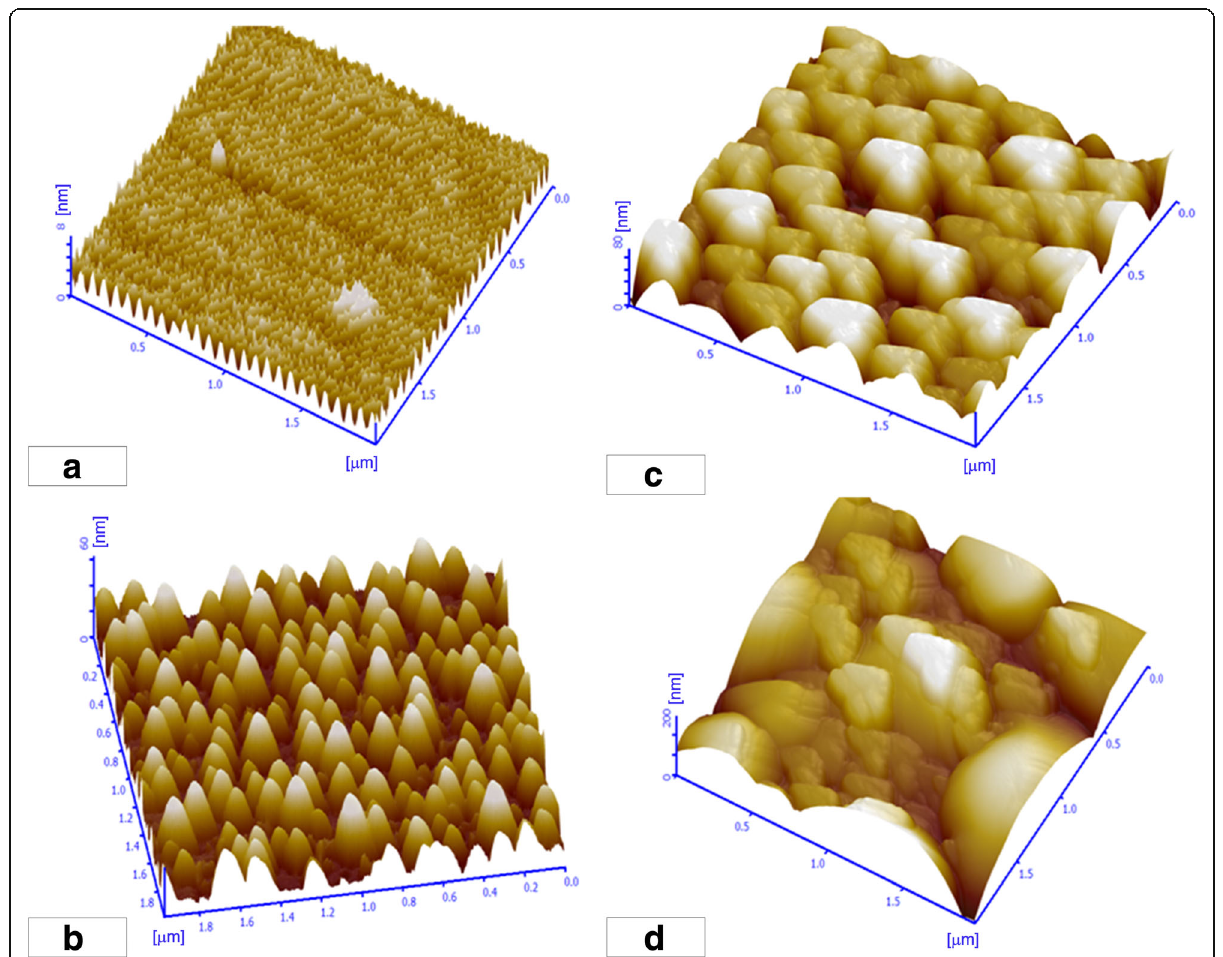
Fig. 3 AFM test results of GeBi films with different Bi contents: a 2.0%; b 10.2%; c 18.3%; and d 20.3%